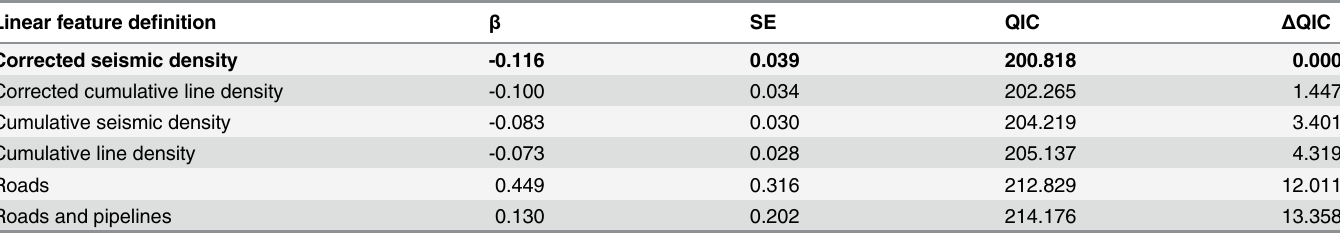
Each model controls for the proportion of lowland forest within the home range, and Julian date at survey commencement. Corrected seismic line and corrected linear feature de fi nitions exclude seismic lines (cid:3) 2